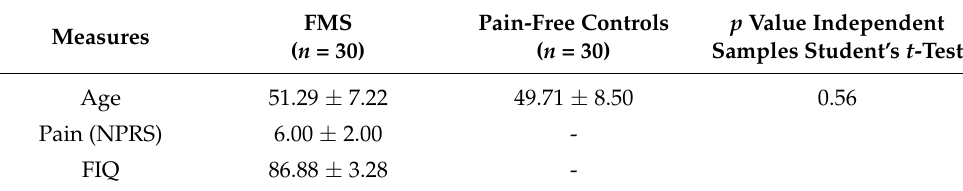
Table 1. Descriptive statistics in demographic measures ( n = 34). Measures